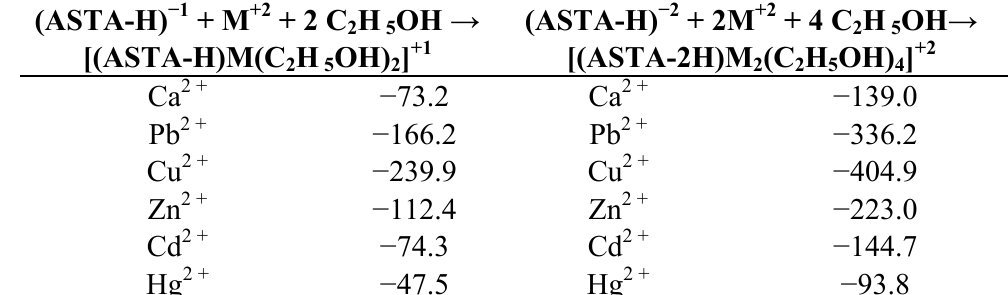
Table 3. Energy differences in ethanol (reported in kcal/mol) for the formation